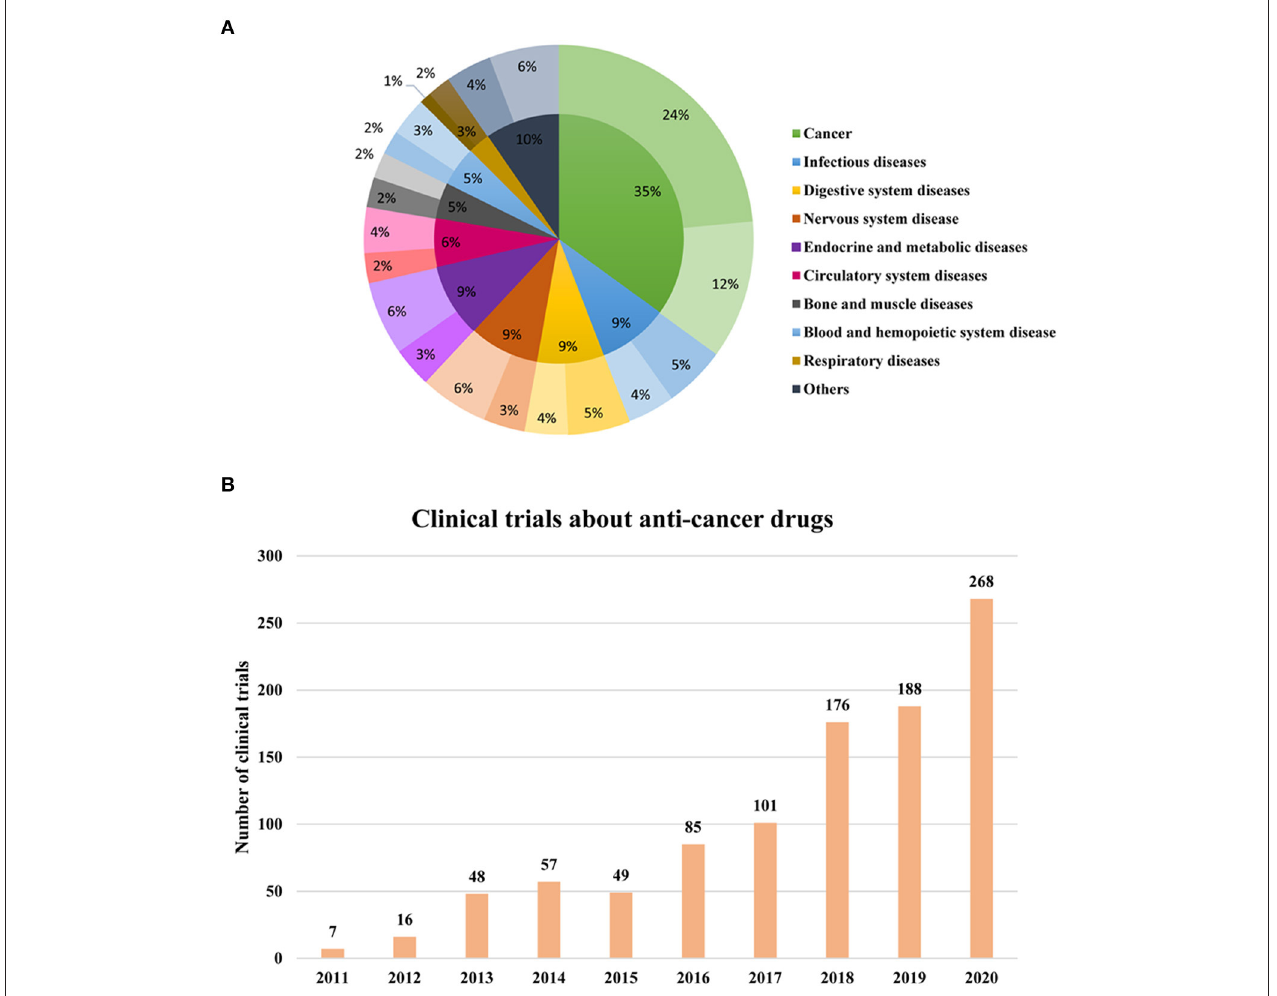
FIGURE 4 | Therapeutic areas of phase I clinical trials during 2011–2020. (A) Therapeutic areas in phase I clinical trials during 2011–2020. The darkest of one color represented phase 1 clinical trials of both innovative and noninnovative drugs; The slighter color shows the phase 1 clinical trials of innovative drugs; The lightest color represented the clinical trials conducted on the noninnovative drug. (B) Annual change of phase I clinical trials about oncology during